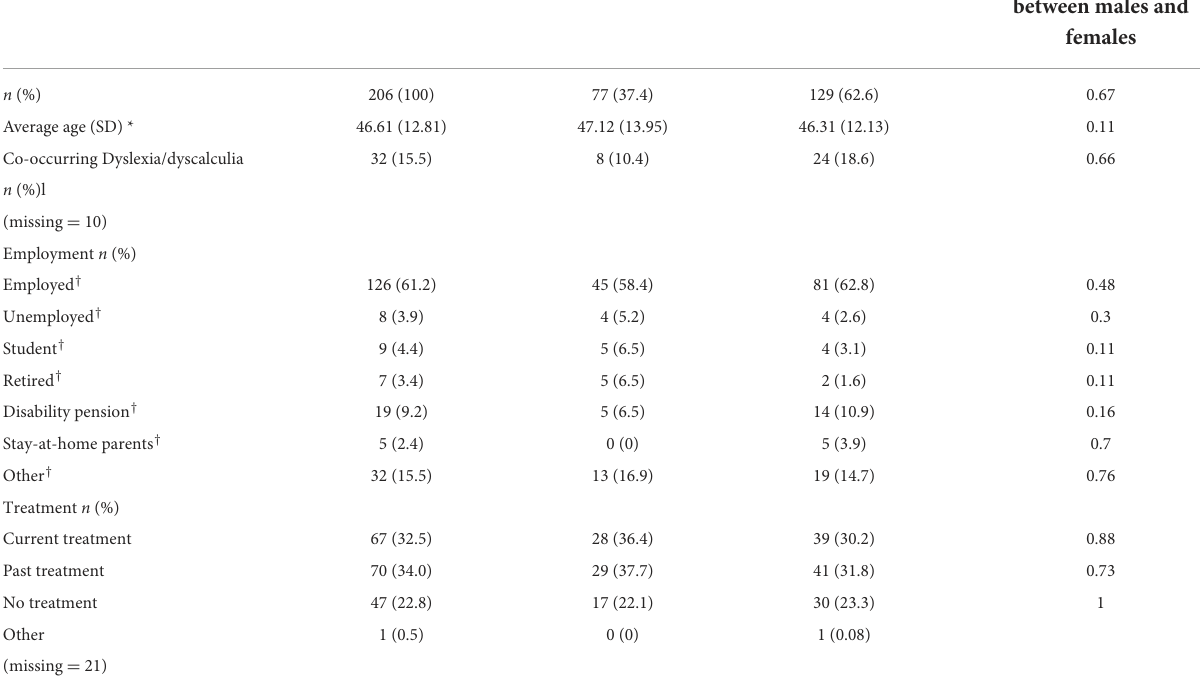
TABLE 1 Demographic characteristics of the study